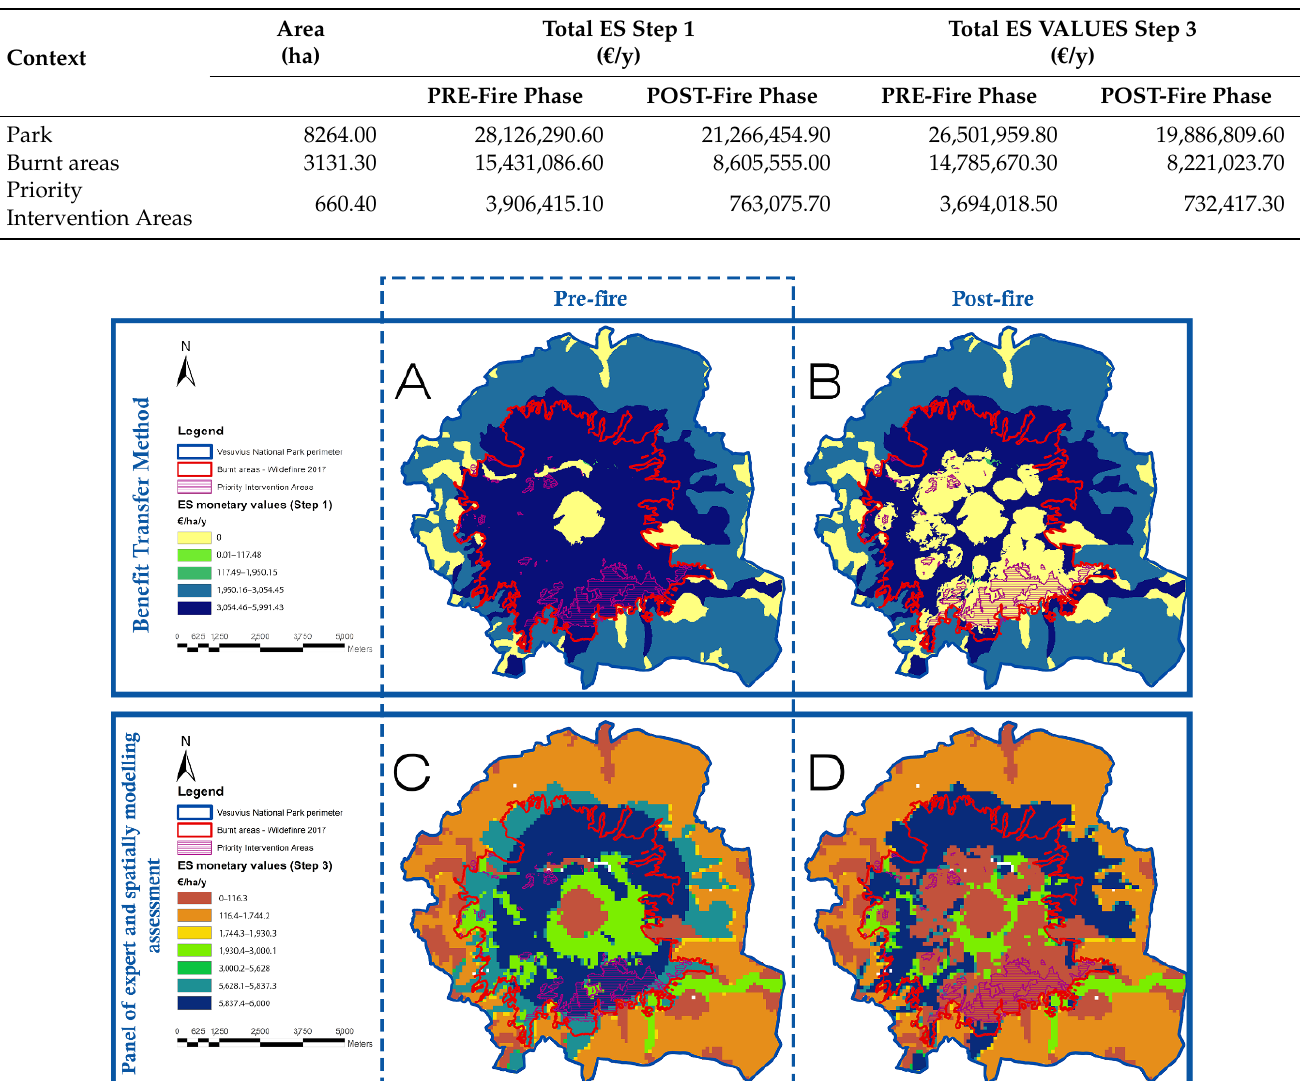
Table 2. ES assessment by means of baseline value and integrated values by means of landscape variables.